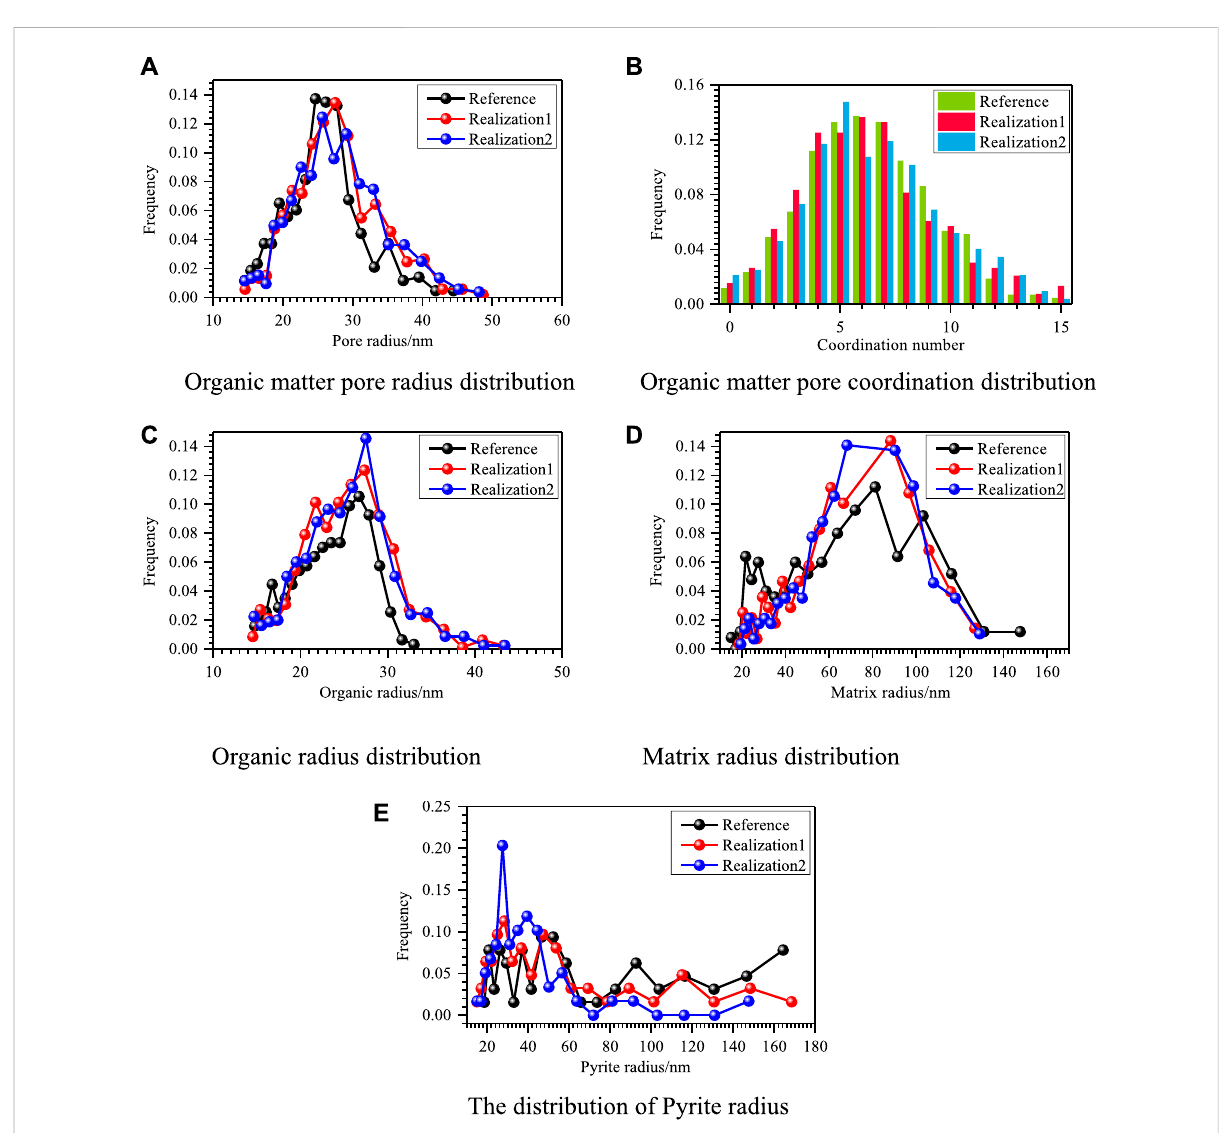
FIGURE 18 Comparison of pore structure distribution of the reference model and two realizations reconstructed by the proposed approach. (A) Organic pore radius distribution, (B) organic pore coordination distribution, (C) organic radius distribution, (D) matrix radius, and (E) pyrite radius. In the pictures (A) , (C) , (D) , and (E) , black is the training image distribution, and red and blue are the distributions of realizations 1 and 2, respectively. In (B) , green is the training image distribution, and red and blue are the distributions of realizations 1 and 2,